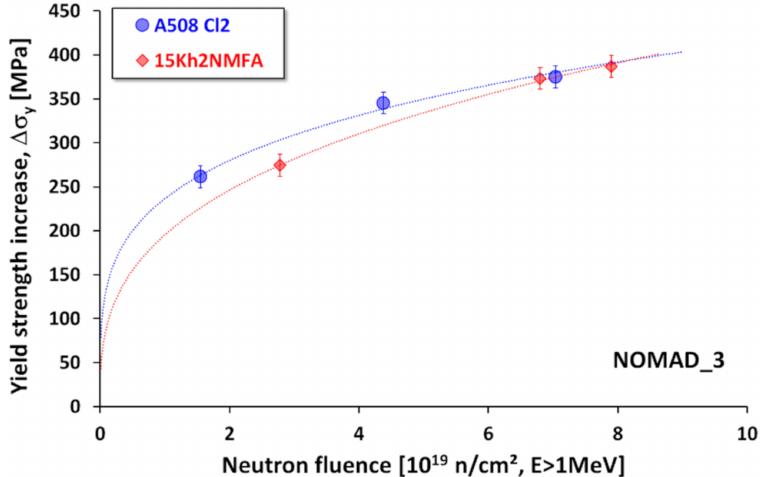
Figure 10. Tensile strength increase (hardening), tested at room temperature for A508 Cl.2 and 15Kh2NMFA steels, as a function of the fast neutron fluence. The dashed lines are added to guide the eye (power law